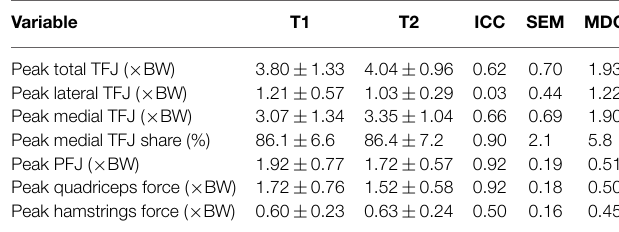
TABLE 5 | Test–retest reliability measures of peak values for nine participants during levelwalking[mean (cid:6) SD,intra-classcorrelationcoefficient(ICC),SEM,andminimal detectable change (MDC)].